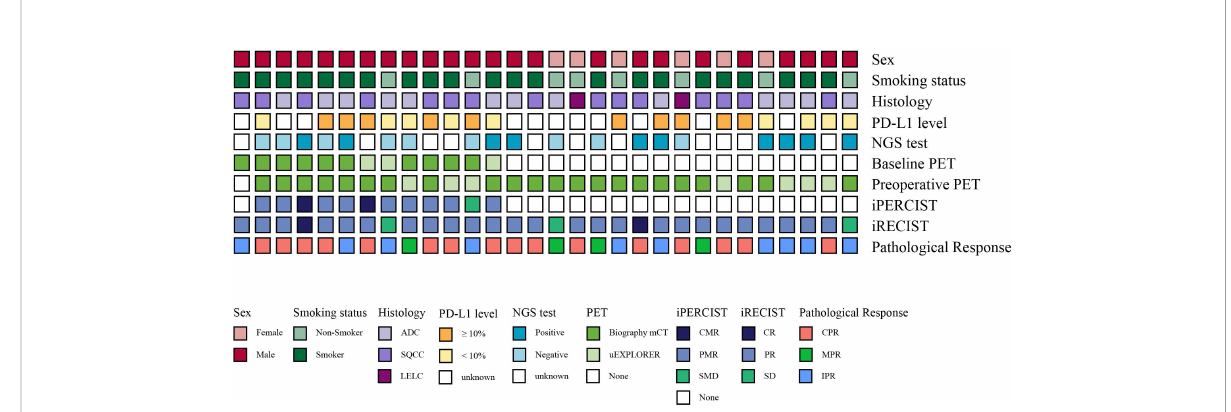
FIGURE 2 Clinical characteristics, radiological responses, metabolic responses, and pathological responses of the enrolled patients. Each bar represents one